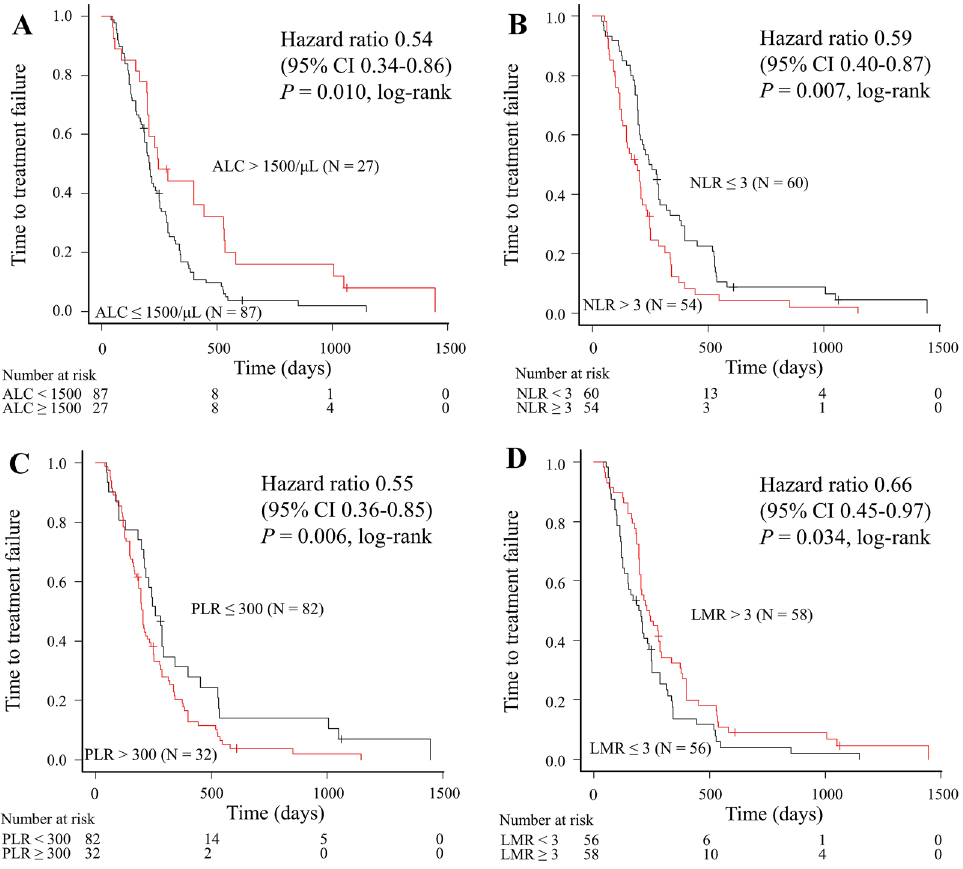
Figure 1. Time to treatment failure according to baseline levels of ( A ) ALC, ( B ) NLR, ( C ) PLR, and ( D ) LMR in patients treated with paclitaxel plus bevacizumab. ALC absolute lymphocyte count, CI confidence interval, LMR lymphocyte-to-monocyte ratio, NLR neutrophil-to-lymphocyte ratio, PLR platelet-to-lymphocyte